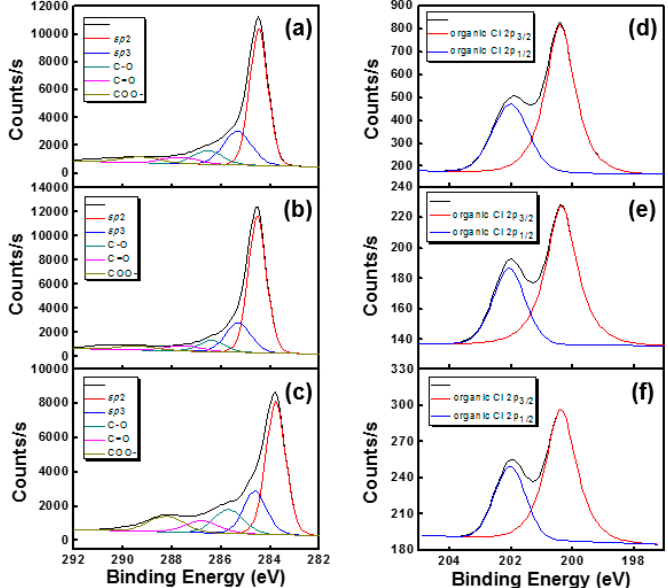
Figure 5. X-ray photoelectron spectroscopy (XPS) peak deconvolution of the C 1s for ( a ) pristine SWNT; ( b ) t-SWNT and ( c ) p-SWNT and Cl 2p peaks for ( d ) pristine SWNT; ( e ) t-SWNT and ( f ) p-SWNT. Table 1. XPS results of the modified SWNTs.